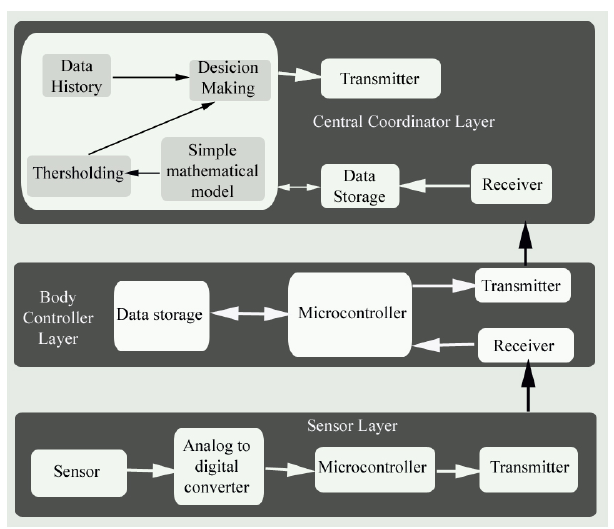
Figure 2. Block diagram of a fog-based